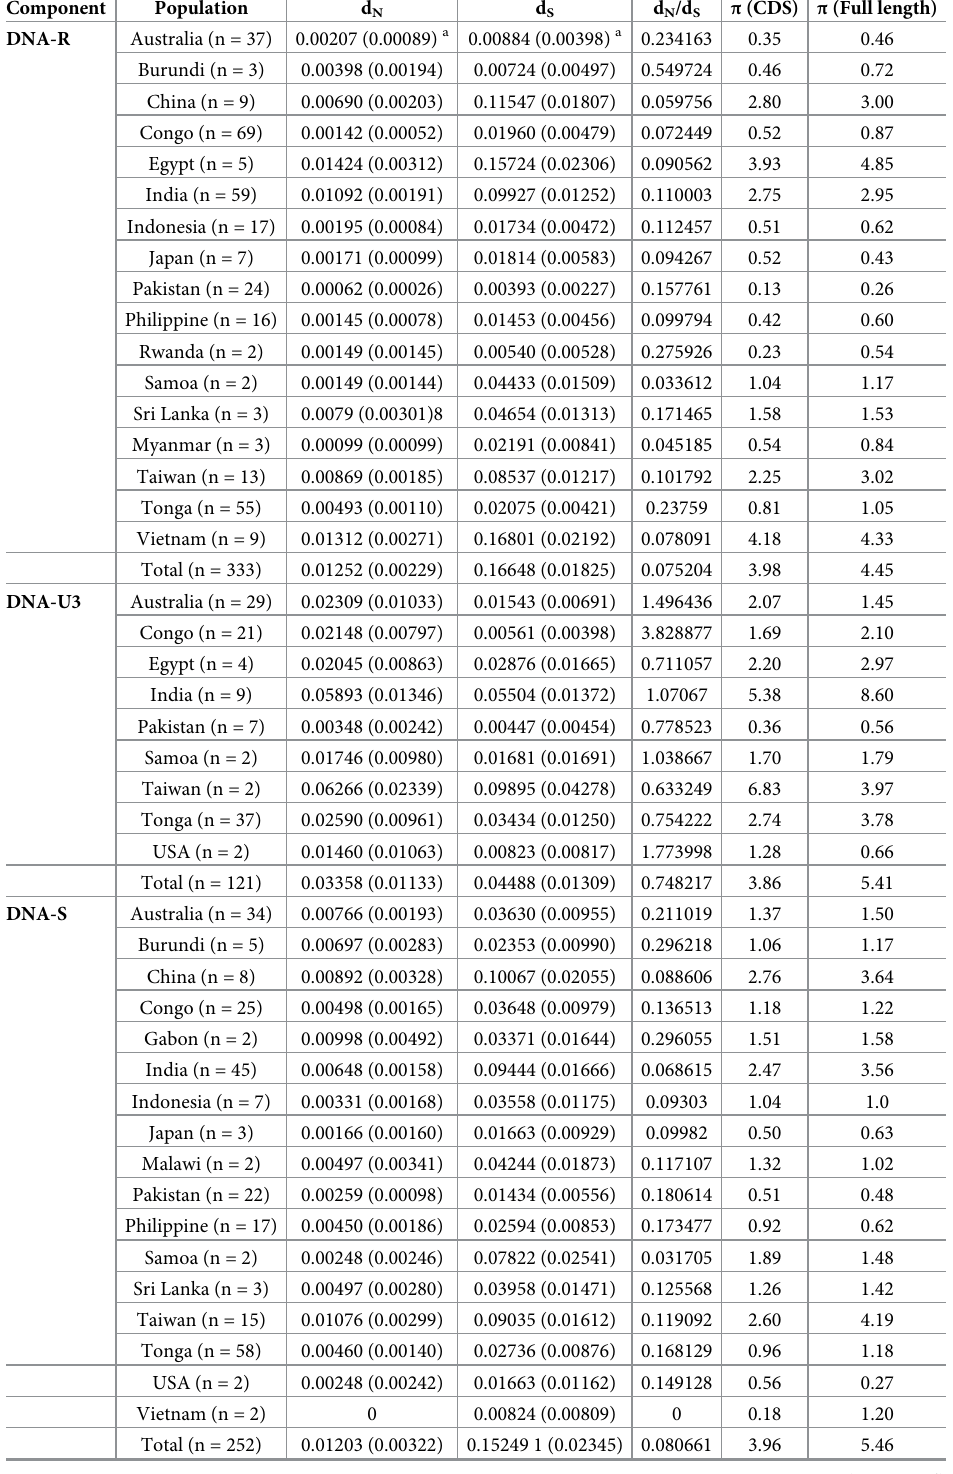
Table 5. Component wise population genetic parameters of Banana bunchy top